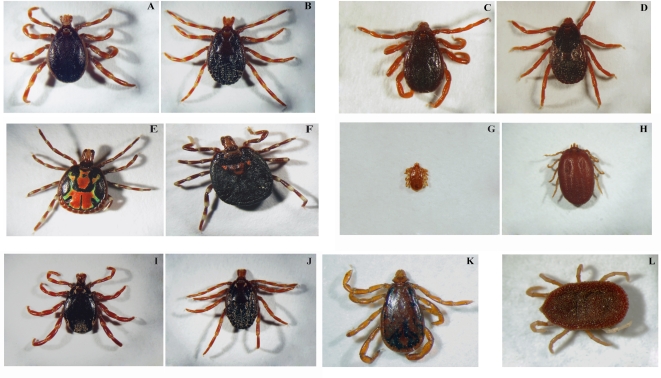
Ticks collected and studies.
Hyalomma marginatum rufipes, male (A), female (B); Rhipicephalus evertsi evertsi, male (C), female (D); Amblyomma variegatum, male (E), female (F); Rhipicephalus (Bophilus) decoloratus, male (G), female (H); Hyalomma truncatum, male (I), female (J); Rhipicephalus guilhoni, male (K); Ornithodoros sonrai (L).